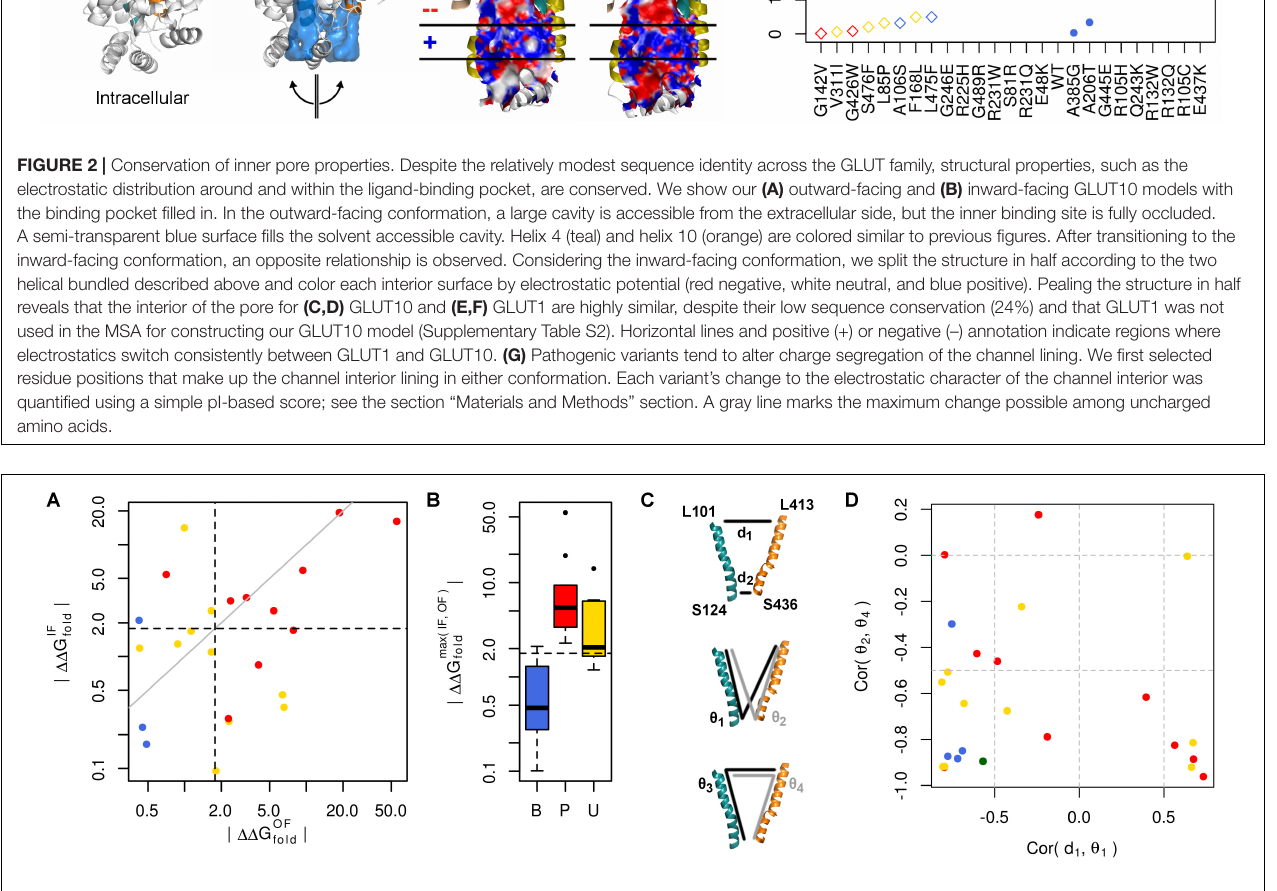
FIGURE 3 | Many pathogenic variants destabilize the protein structure. (A) Variants of each class are clearly separated from one another by their effect on protein folding energy. We calculated (cid:49)(cid:49) G fold for each variant using our structural models of both the IF and OF conformations. Black dashed lines indicate (cid:49)(cid:49) G = 3 k B T, while the gray line indicates equivalence. L475F was omitted from the scatterplot because it had a near-zero (cid:49)(cid:49) G fold in both conformations. (B) Significant differences are observed between each group of variants with known pathogenic variants exhibiting greater (cid:49)(cid:49) G fold than benign variants ( p = 0.031). Many VUSs also destabilize the protein structure ( p = 0.016). Known pathogenic variants were not significantly more destabilizing than VUSs ( p = 0.910). (C) Variants often disrupt communication through the structure. Residues at the ends of H4 and H10, colored as in previous figures, are used as conformational monitors. (D) For the IF WT model as a representative example and benign variants, there is a strong negative correlation between the angle, θ 1 , and distance, d 1 . This relationship indicates that as θ 1 increases, corresponding to opening of the intracellular side, d 1 decreases, corresponding to the closure of the extracellular side. Similar relationships are observed for the opposite pattern, such as the negative correlation between the angles θ 2 and θ 4